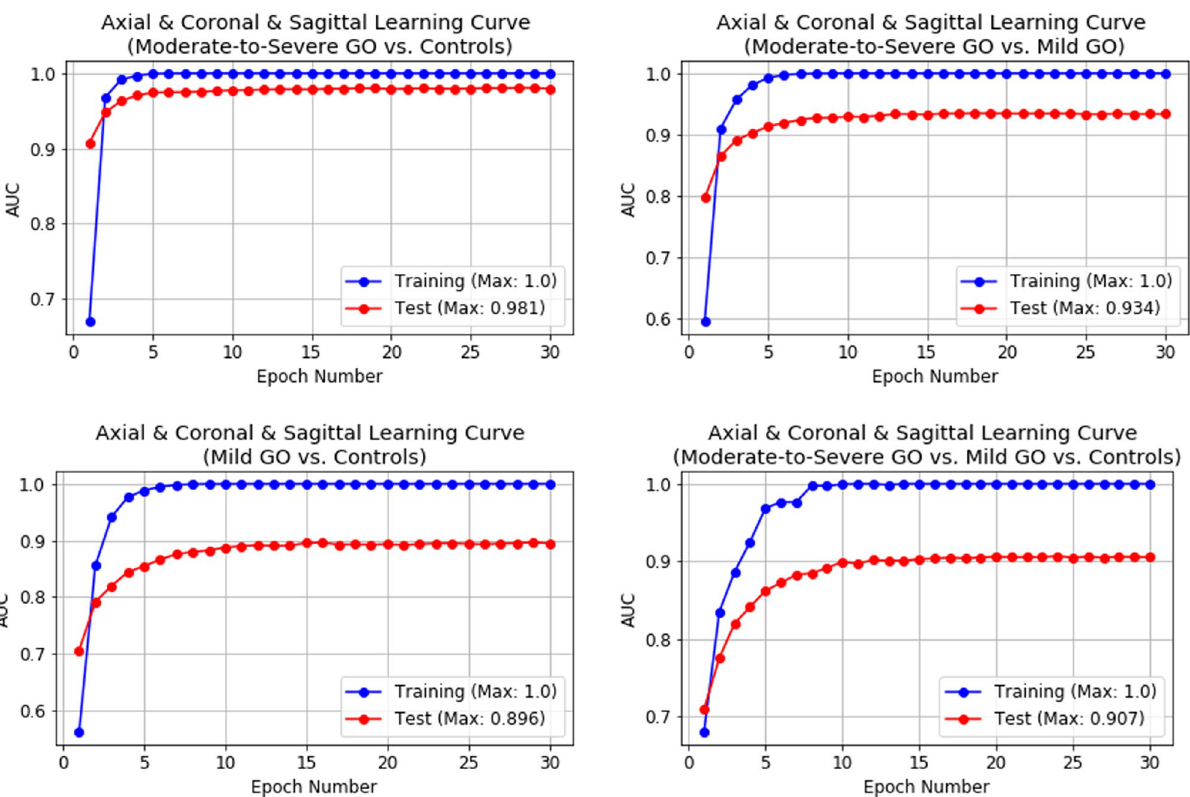
Figure 2. Learning curves of proposed neural network at each epoch averaged over 30 experiments. The blue and red lines correspond to the training and test datasets, respectively. Both lines in each case indicate the best performance at the 10th epoch without oscillation, and the area under the receiver operating characteristic curves (AUC) of all the learning curves increase monotonically. GO Graves’